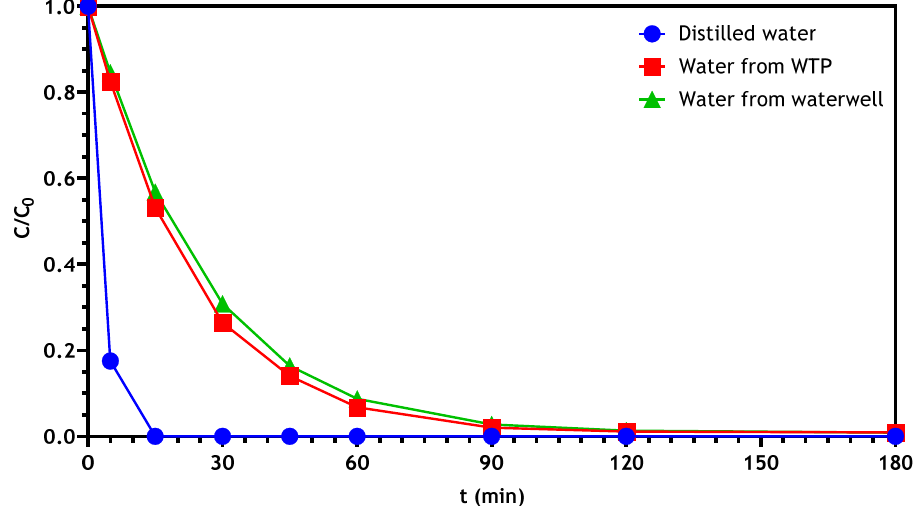
Figure 7. Dimensionless bromate concentration during semi-batch hydrogen reduction over the catalyst 1 wt.% Pd/MWCNT-BM using different types of water. (H 2 = 50 cm 3 min − 1 , C 0 (BrO 3 − ) = 200 ppb, 0.125 g CAT L − 1